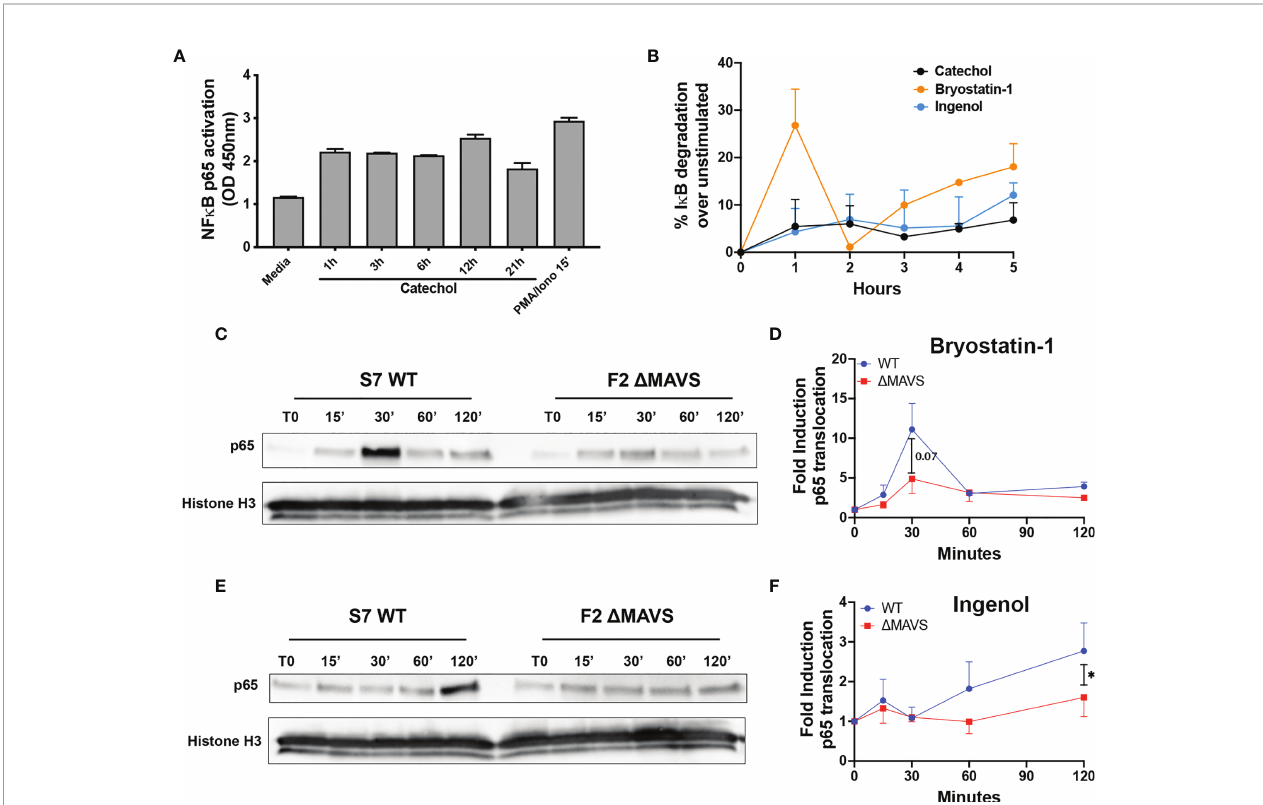
FIGURE 5 | Activation of p65 by Catechol, Bryostatin-1 and Ingenol. (A) Total CD4T cells from one donor were treated with 25 m M of Catechol or PMA/Ionomycin at the indicated times. p65 transcriptional activity was measured in total cell extracts using the TransAM NF- k B p65 kit. (B) Memory CD4T cells from two donors were treated with Catechol, Ingenol or Bryostatin-1 at the indicated time points and degradation of I k B- a was assessed by fl ow cytometry. (C) Representative western blot of the levels of p65 nuclear translocation after treatment of WT and D MAVS J-Lat clone with Bryostatin-1 for the time points indicated. (D) Fold induction relative to time 0 (T0) for three independent experiments were quanti fi ed by densitometry. (E) Representative western blot of the levels of p65 nuclear translocation after treatment of WT and D MAVS J-Lat clone with Ingenol for the time points indicated. (F) Fold induction relative to time 0 (T0) for three independent experiments were quanti fi ed by densitometry. Ratio paired t-test analysis was used to calculate p-values. (*p <